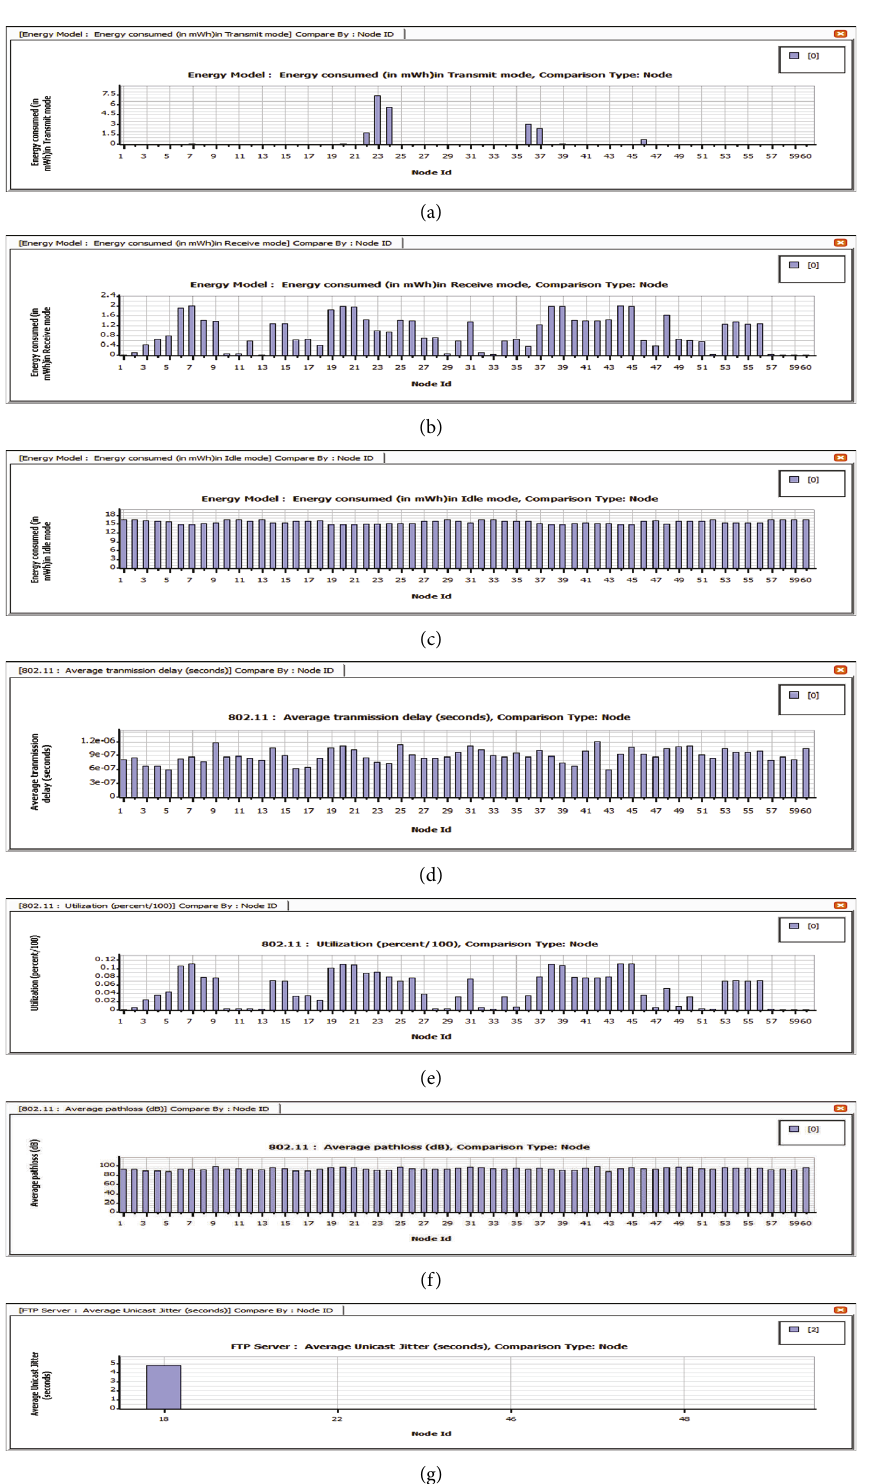
Figure 15: (a) Transmit mode energy consumption of STAR-LORA for FTP deployment. (b) Receive mode energy consumption of STAR- LORA for FTP deployment. (c) Idle mode energy consumption of STAR-LORA for FTP deployment. (d) Average transmission delay of STAR-LORA for FTP deployment. (e) Percentage of utilization of STAR-LORA for FTP deployment. (f) Average pathloss of STAR-LORA for FTP deployment. (g) Average jitter of STAR-LORA for FTP